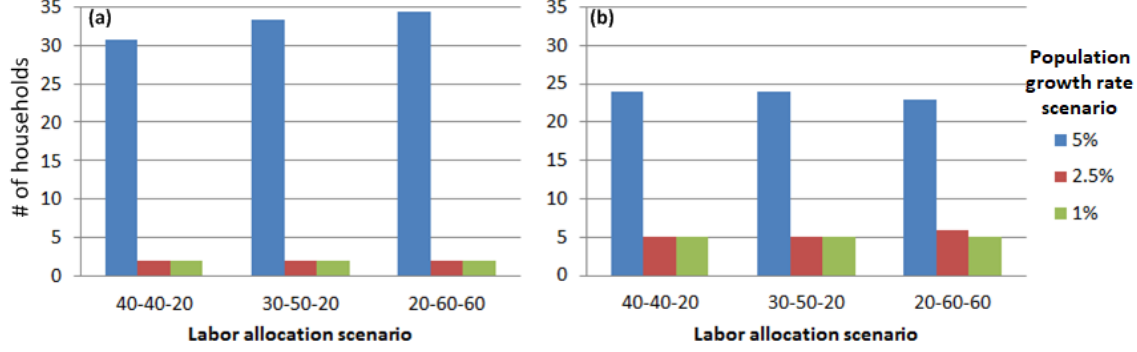
Figure 3. Adoption of biogas ( a ) and other bioenergy alternatives ( b ) under different labor allocations and population growth scenarios .